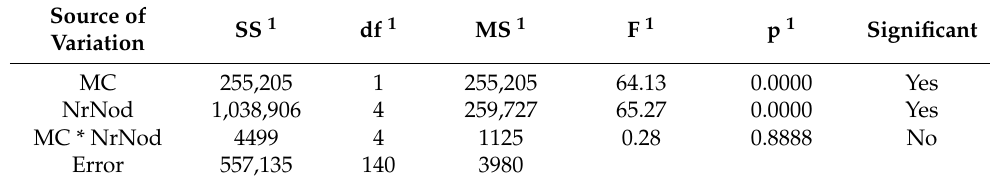
The results of the analysis of variance are presented in Table 5, Table 6, Table 7 and Table 8. Table 5. Two-way ANOVA results for modulus of elasticity in compression (MOE compr ). Source of Variation